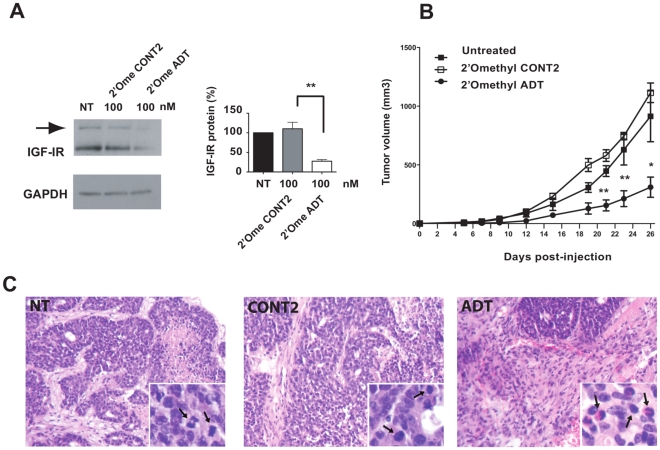
Transfection with siRNAs targeting IGF-IR alters in vivo growth of C4HD cells.(A) Western blot after 48 h transfection of C4HD cells with 2′-O-methyl siRNAs. Representative experiment is presented and quantitative analysis of three independent experiments is shown on the right of the blot with means ± SEM with black bars corresponding to mock transfected cells (NT). ** P<0.01. (B) After 48 h, treated cells were inoculated s.c. into mice. C4HD cells were transfected either with 2′-O-methyl ADT siRNA, which targets mIGF-IR (•), the control 2′-O-methyl CONT2 siRNA (□) or remained untreated (▪). Each data point represents the mean tumor volume ± SEM, n = 5. * P<0.05; ** P<0.01, ANOVA referred to untreated group. (C) Tissue sections of C4HD tumors obtained from mice in each group. Mice inoculated with untreated C4HD cells (NT), with C4HD cells transfected with the control 2′-O-methyl CONT2 siRNA (CONT2), or with the 2′-O-methyl ADT siRNA (ADT). Tumor shows atypical features, necrosis and several mitotic figures indicated with arrows (inset, H&E ×400). ADT sections show necrosis and inflammatory fibrosis (H&E ×40). Infiltration of lymphocytes and granulocytes is shown (inset, H&E ×400).